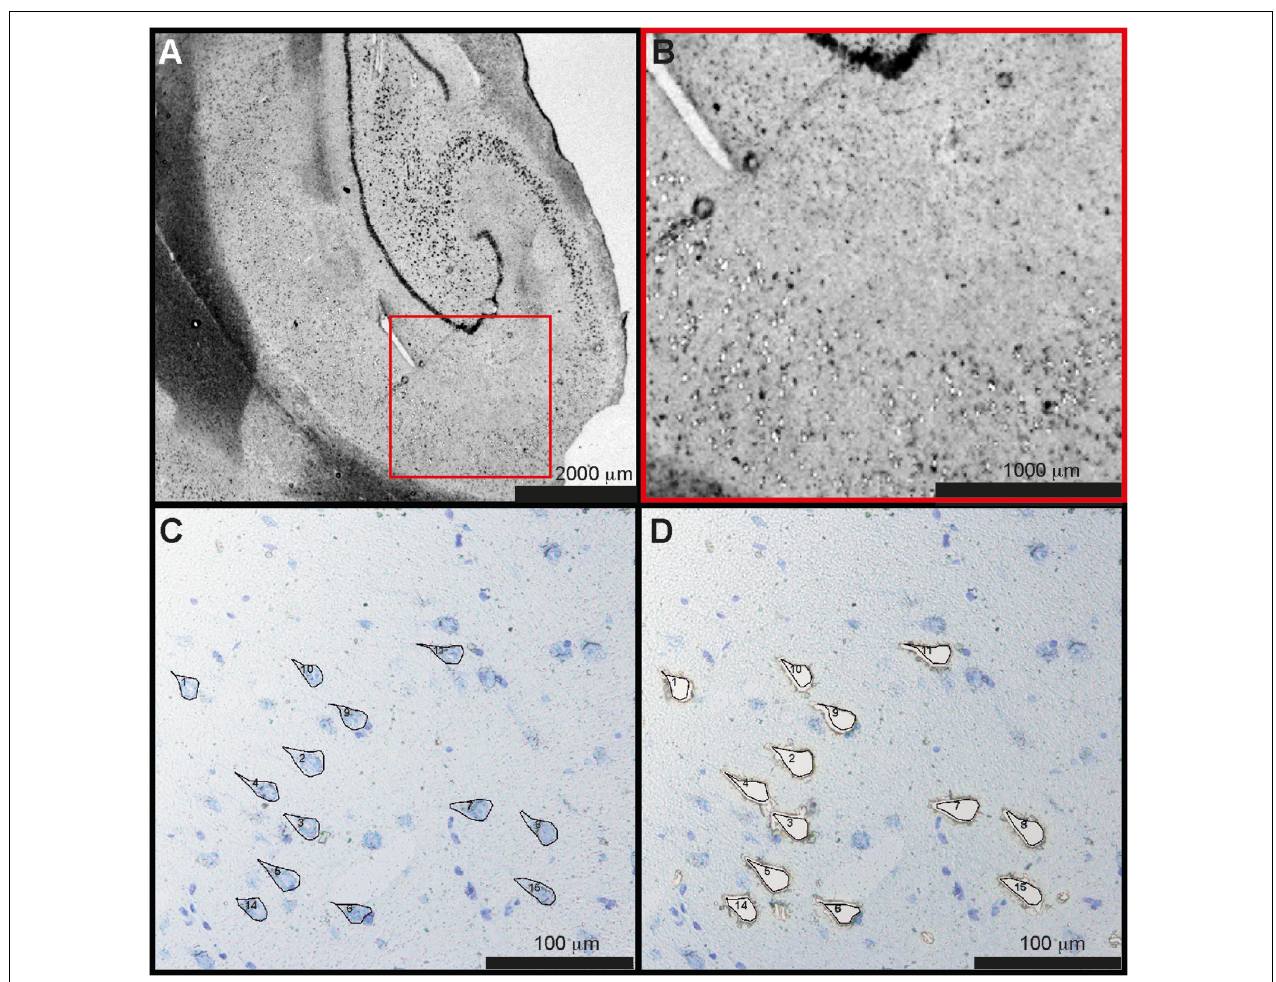
FIGURE 1 | Laser capture microdissection of CA1 neurons. (A) Overview of the hippocampal section from one control case. (B) Magnified part of CA1 with individual, pyramidal cells microdissected from the tissue. (C) Pyramidal cells stained by toluidine blue were marked manually and (D) microdissected. A total of 1,000 neurons were dissected from each subject. CA1, cornu ammonis